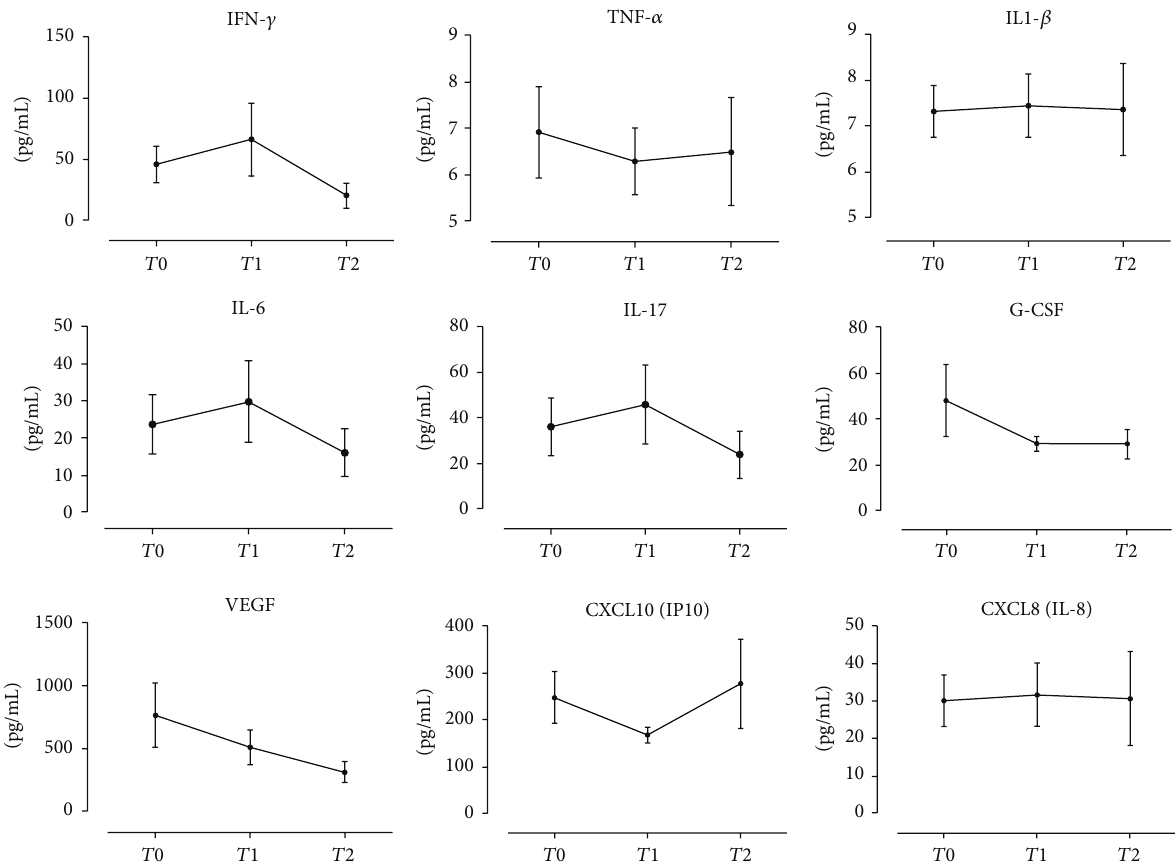
Figure 2: Cytokine levels at different time points in PR patients: at onset of the disease ( 𝑇 0 ), after 15 days ( 𝑇 1 ), and after 30 days ( 𝑇 2 ).